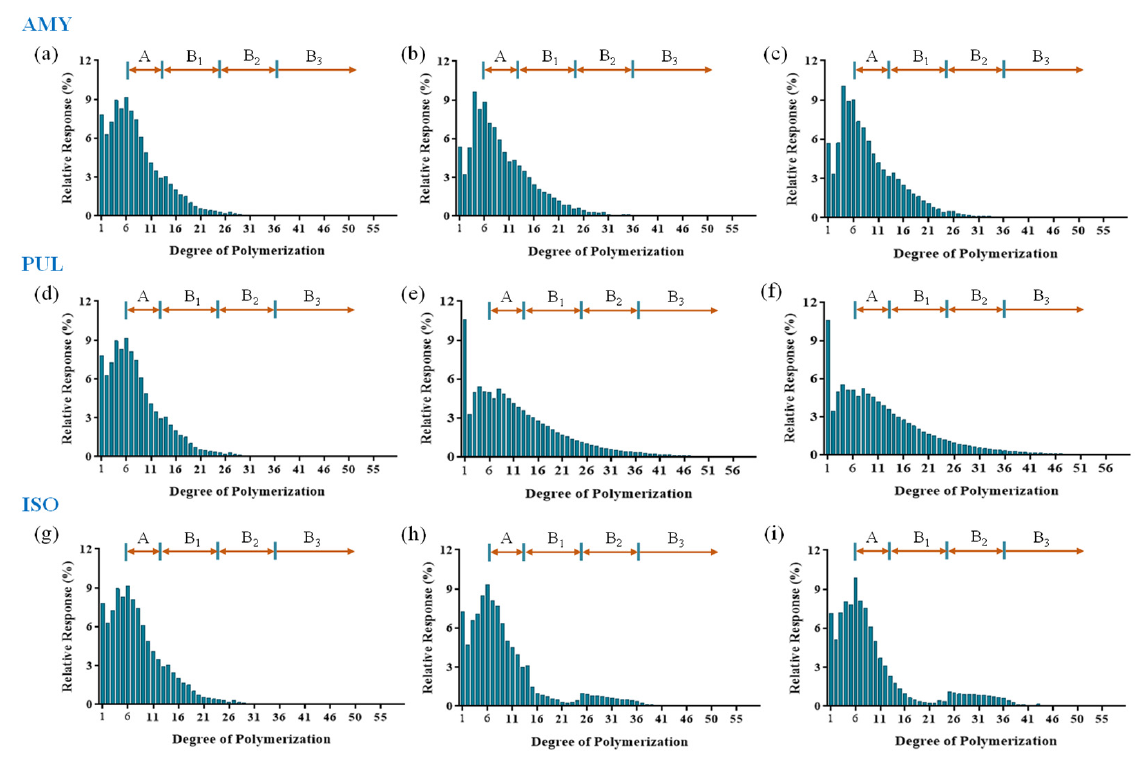
Figure 3. Chain length distribution of hydrolysates was obtained by debranching DE6 maltodextrin using AMY, PUL, and ISO, respectively. ( a – c ) were treated by AMY with 0, 6 and 24 h; ( d – f ) were treated by PUL with 0, 6 and 24 h; ( g – i ) were treated by ISO with 0, 6 and 24 h. Compared with AMY, PUL and ISO had different debranching specificities. The chain length distribution and average chain length changed significantly after PUL treatment, which resulted in an altered maximum peak value. Interestingly, the glucose content increased dramatically after PUL treatment, indicating that PUL hydrolyzed not only α - 1,6-glycosidic bonds but also α -1,4-glycosidic bonds [38]. The proportion of DP 13–24, DP 25–36, and DP ≥ 37 fractions increased significantly with increasing PUL treatment time. A reasonable explanation may be that PUL randomly cleaved α -1,6-glycosidic bonds at the branching points and α -1,4-glycosidic bonds in the linear chain, generating a mixture of linear chains with different degrees of polymerization. On the other hand, the debranching products of ISO contained a greater proportion of long linear chains than AMY. The proportion of DP 25–36 fractions increased significantly from 1.13% to 10.27%, while the glucose content did not change significantly. The results indicated that ISO tended to cleave α -1,6-glycosidic bonds of the long branched chain in amylopectin, and has no